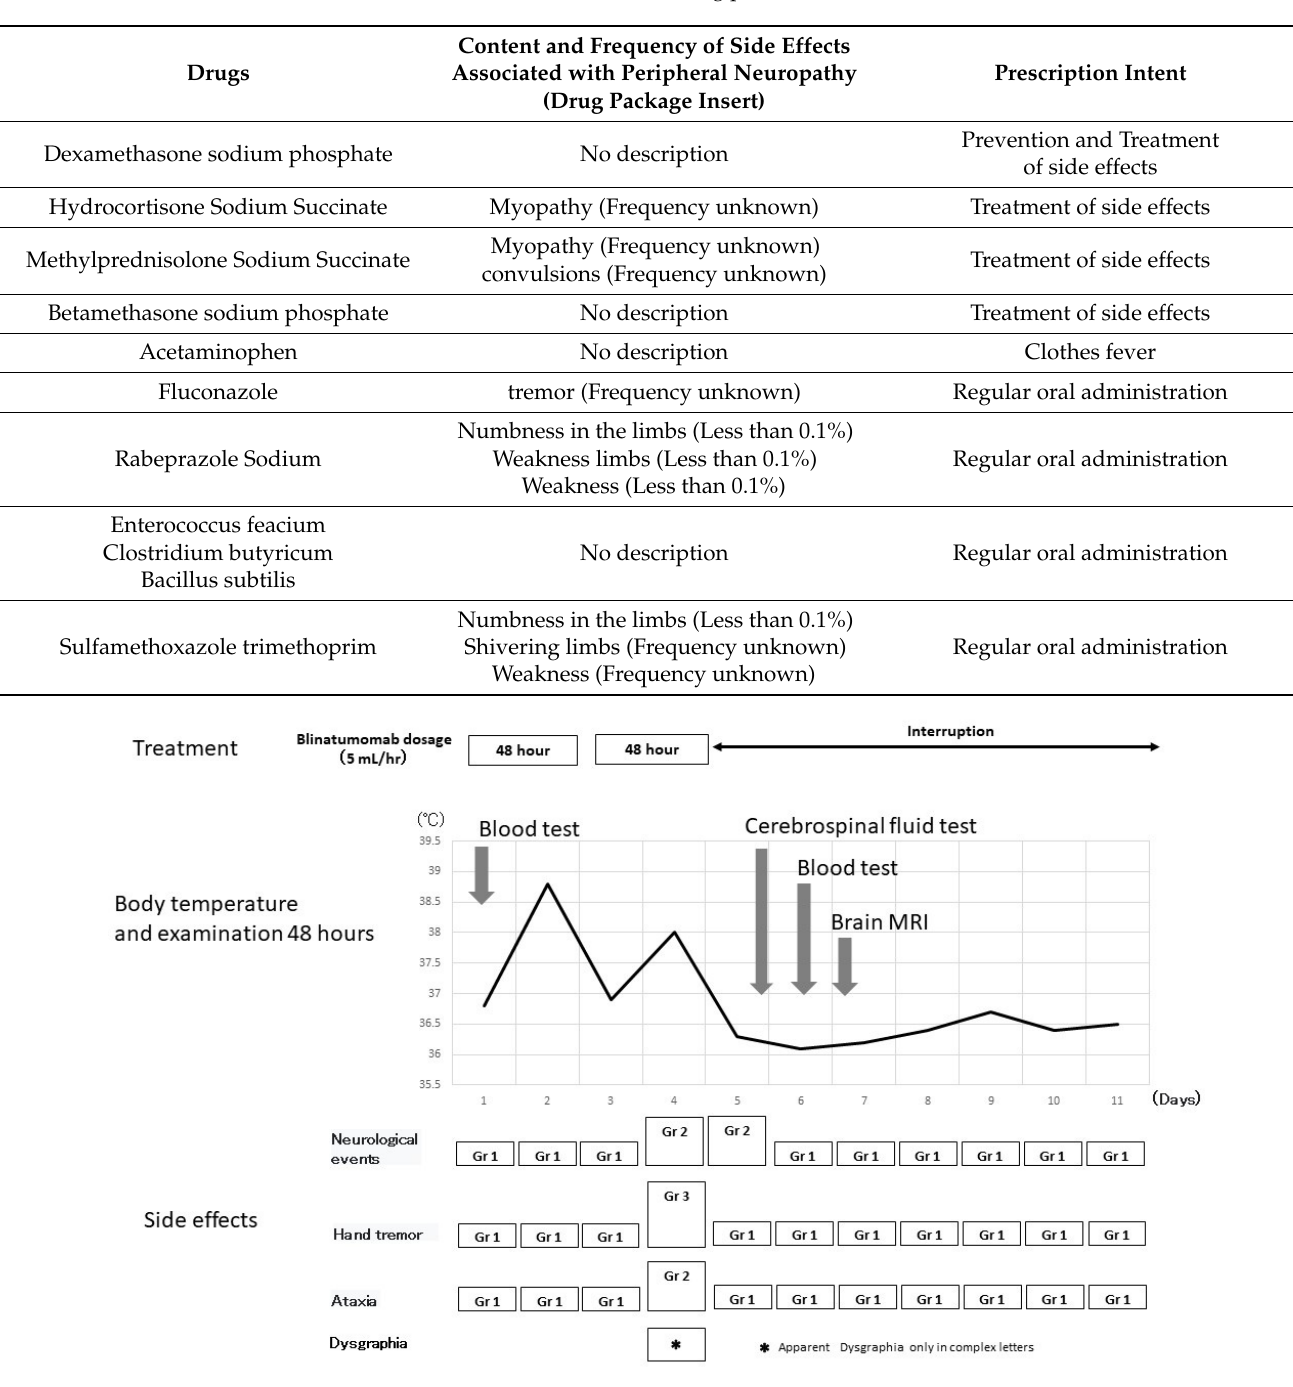
Table 2. Drugs used during Blinatumomab administration. The patient was not taking any medica- tions that could have caused the writing problems.